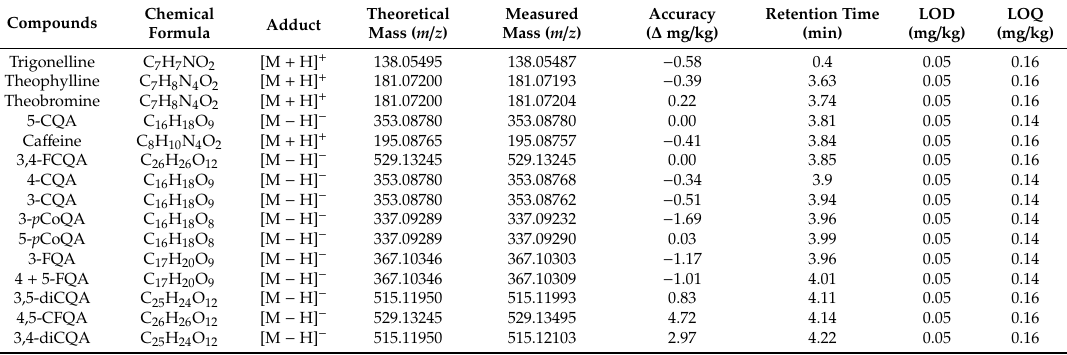
Table 2. Chromatographic and spectrometric parameters including ion assignment, theoretical and measured mass ( m / z ), retention time, accuracy, and sensitivity for the investigated analytes ( n = 15). FCQA, feruloyl-ca ff eoylquinic acid; p CoQA, p -coumaroylquinic acid; CFQA, ca ff eoyl-feruloylquinic.